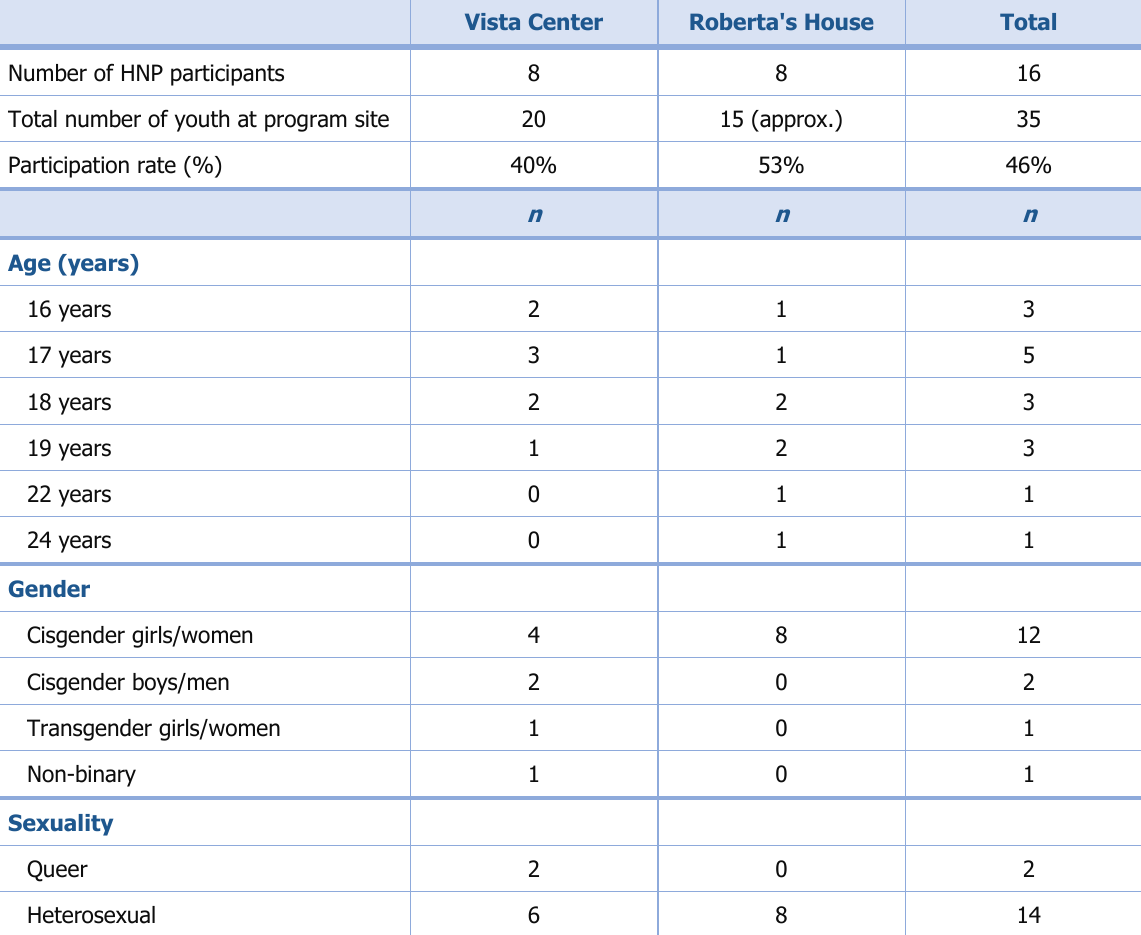
Table 1. Research Site Participation and Demographic Information (N = 16) Vista